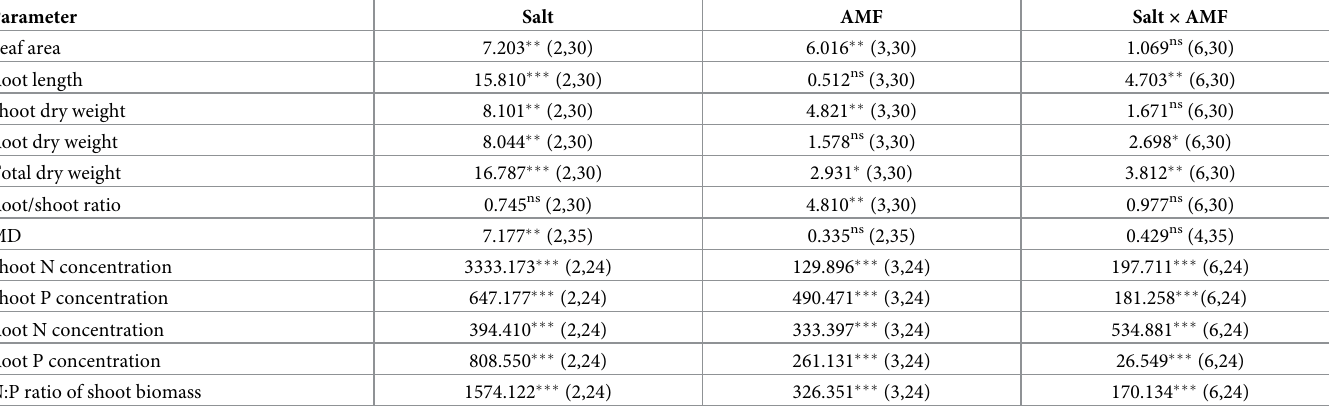
Table 2. Effects of salt, arbuscular mycorrhizal fungi (AMF) and their interactions on growth and nutrient parameters of Chrysanthemum morifolium plants. Parameter